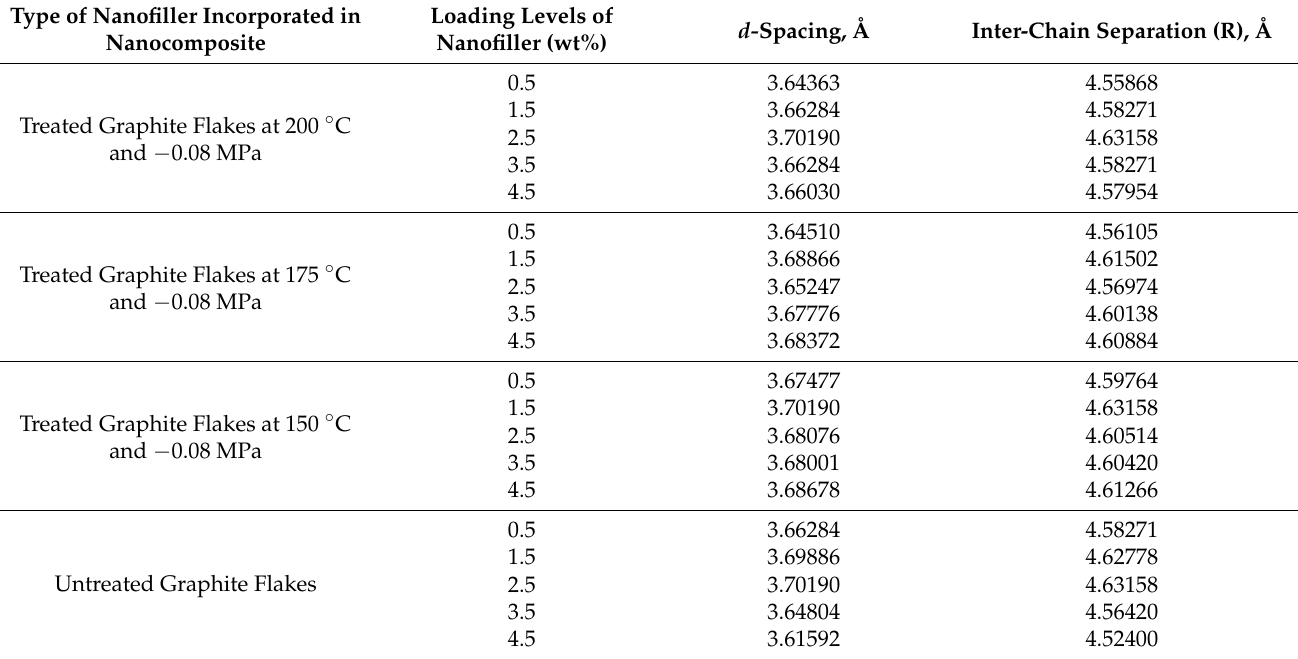
Table 3. d-spacing and Inter-chain Separation for All 2 θ = 24.1 ◦ peaks in Nylon